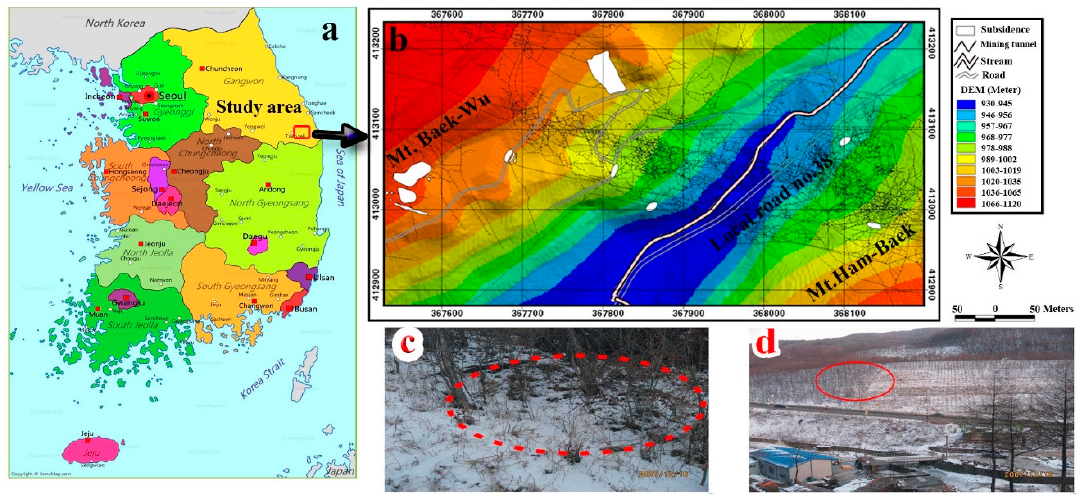
Figure 1. Study area; ( a ) Geographic location of the study area in the northeast of South Korea; ( b ) Location of study area between Mt. Baek-Wu to the west and Mt. Ham-Beak to the southeast; ( c ) and ( d ) the pictures at the surveyed subsidence locations that were taken from field surveys.